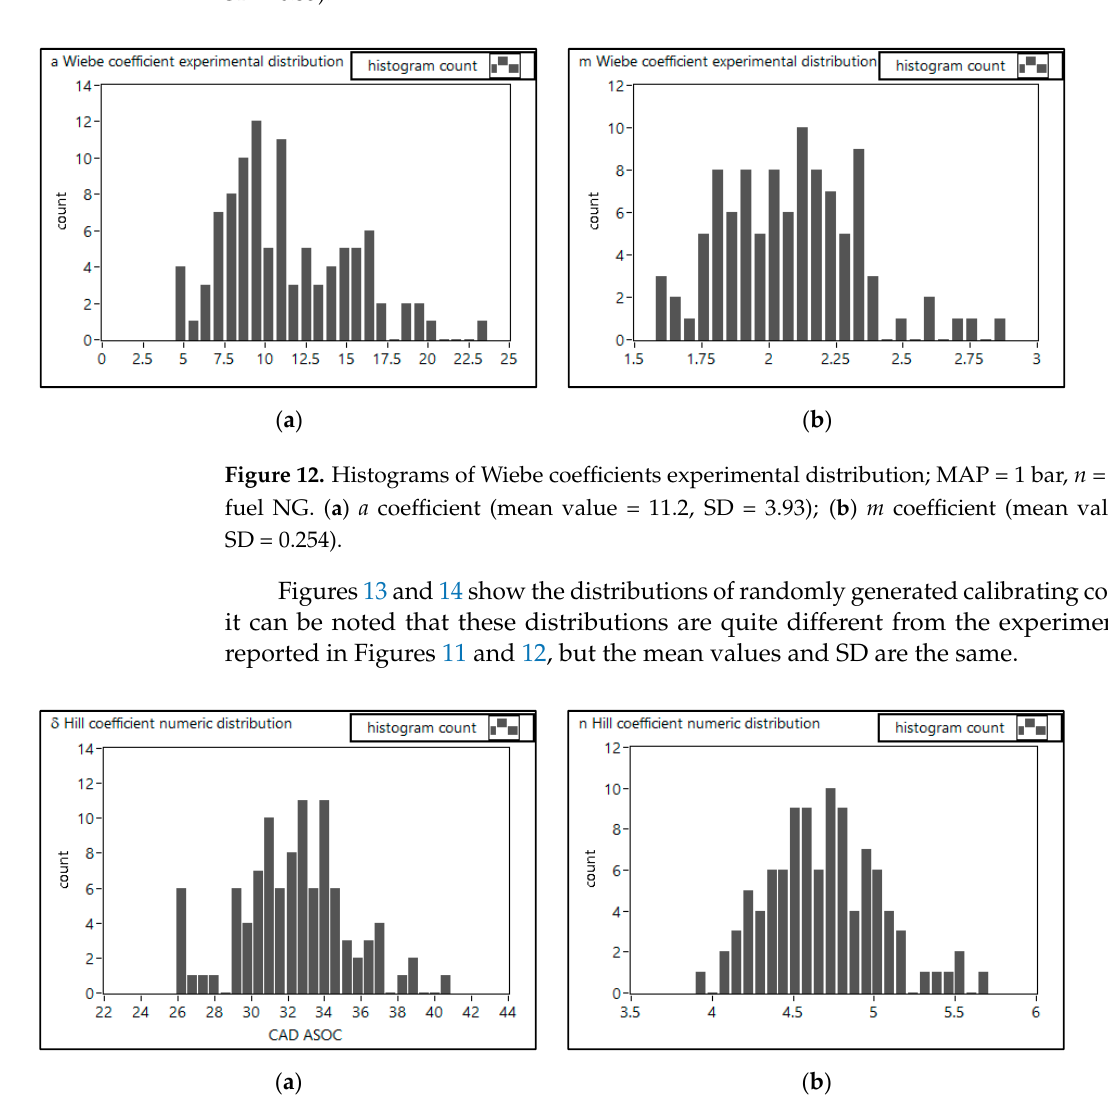
( b ) Figure 14. Histograms of Wiebe coefficients numeric distribution; MAP = 1 bar, n = 3500 rpm, fuel NG. ( a ) a coefficient (mean value = 11.2, SD = 3.93); ( b ) m coefficient (mean value = 2.08, SD = 0.254). Figure 15a,b report the 100 consecutive pressure curves obtained by the 0-D simula- tion model described in [11] using the Hill and Wiebe equations, respectively. ( a ) ( b ) Figure 15. 100 simulated pressure cycles; MAP = 1 bar, engine speed n = 3500 rpm, fuel 100% NG. ( a ) using the Hill function; ( b ) using the Wiebe function. 65 5101520253035 4045505560 CAD ATDC 80-50 -40 -30 -20 -10 0